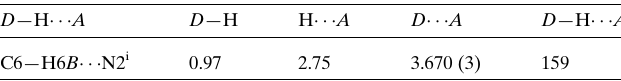
Table 2 Experimental